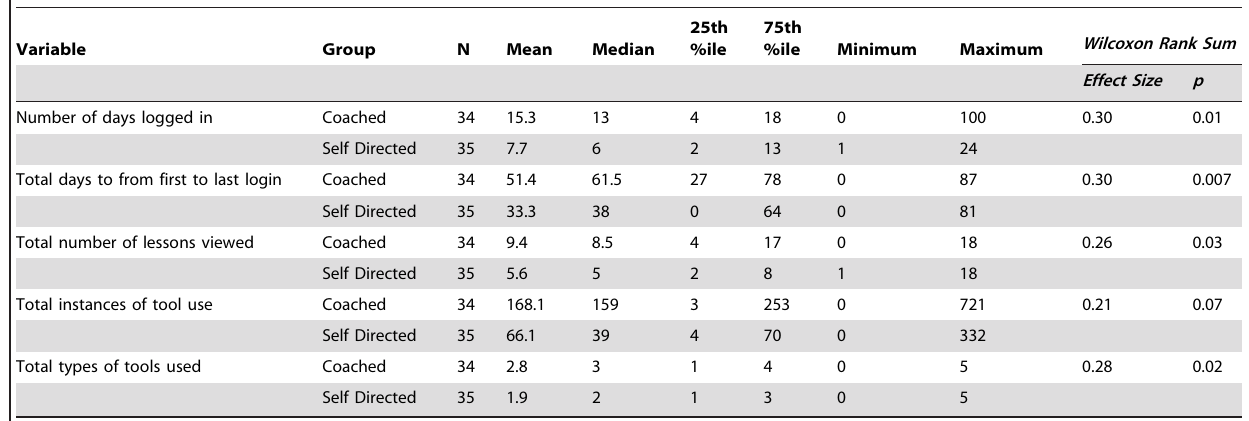
Table 2. Intervention Adherence.